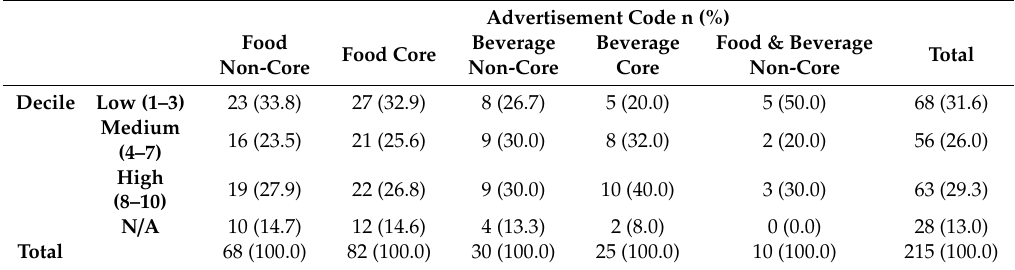
Table 3. Proportion of Food and Beverage Advertisements by School Decile.